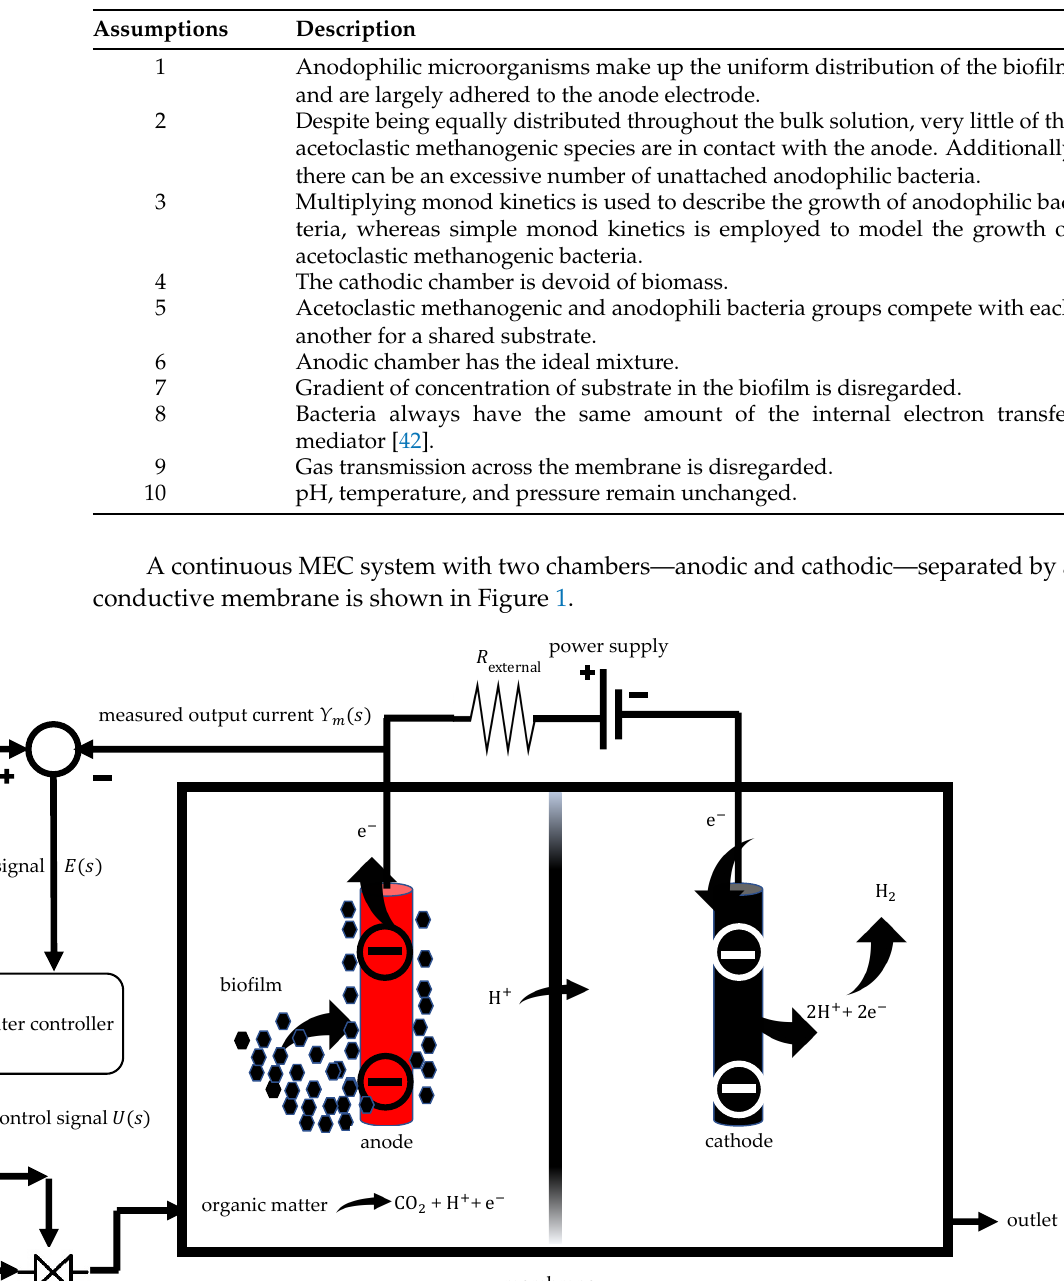
Table 1. Model’s assumptions.